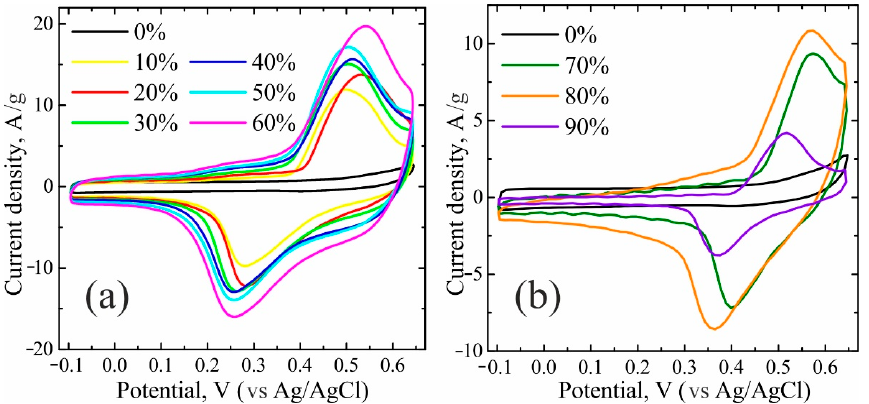
Figure 4. Cyclic voltammograms (CVs) of NiO/C samples, divided into two groups with NiO concentrations of: ( a ): 0, 10, 20, 30, 40, 50, 60 wt%; ( b ) 0, 70, 80, 90 wt%.